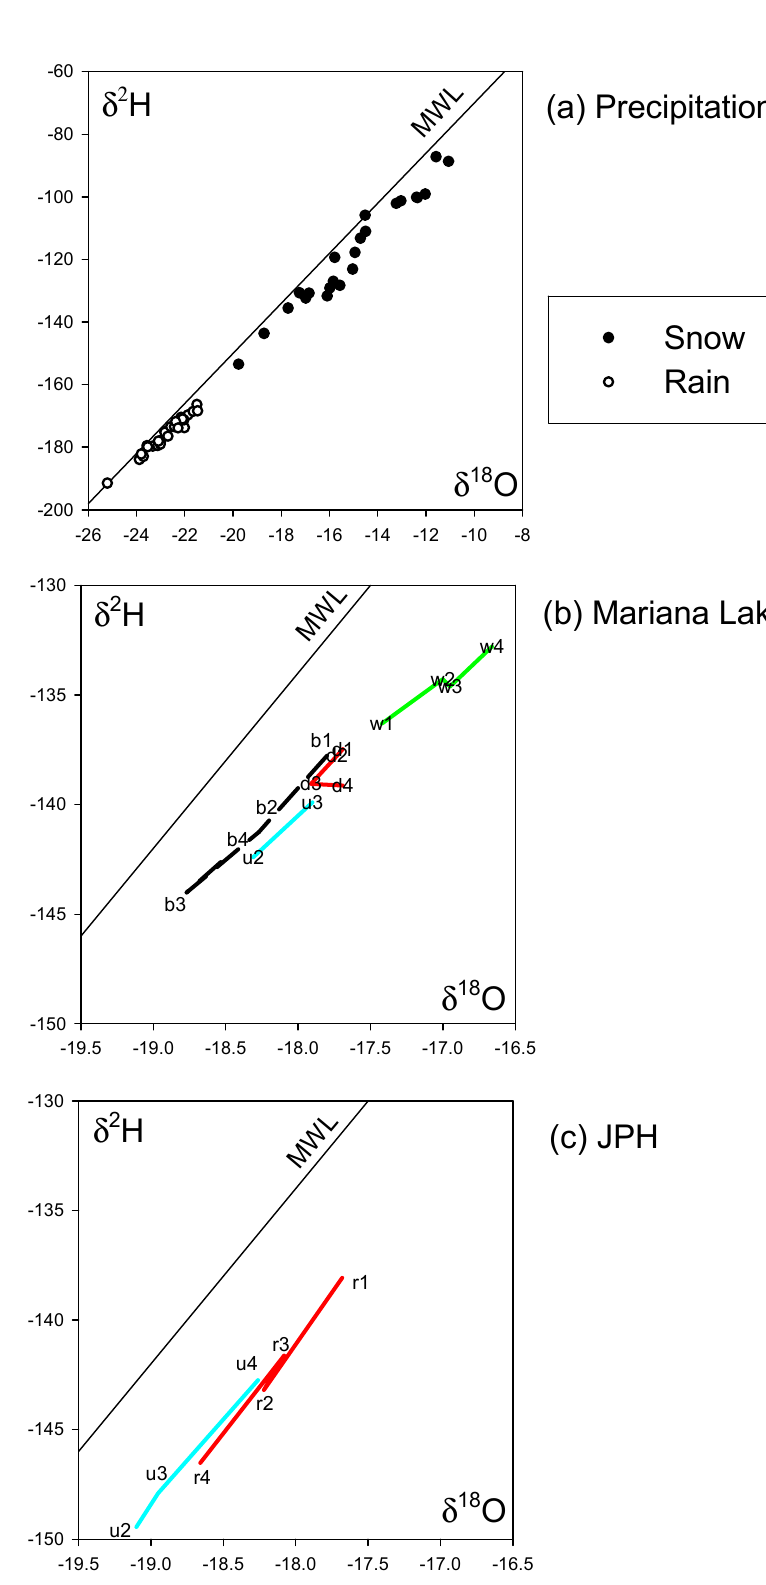
Figure 5. Isotopic composition of ( a ) precipitation (snow and rain), and average isotopic composition of water table wells, and shallow to deep piezometers ( b ) Mariana Lakes, and ( c ) Jack Pine High. Note that b—bog, d—dry fen, w—wet fen, r—rich fen, u—upland; 1—water table, 2—shallow piezometers, 3—intermediate piezometers, 4—deep piezometers.